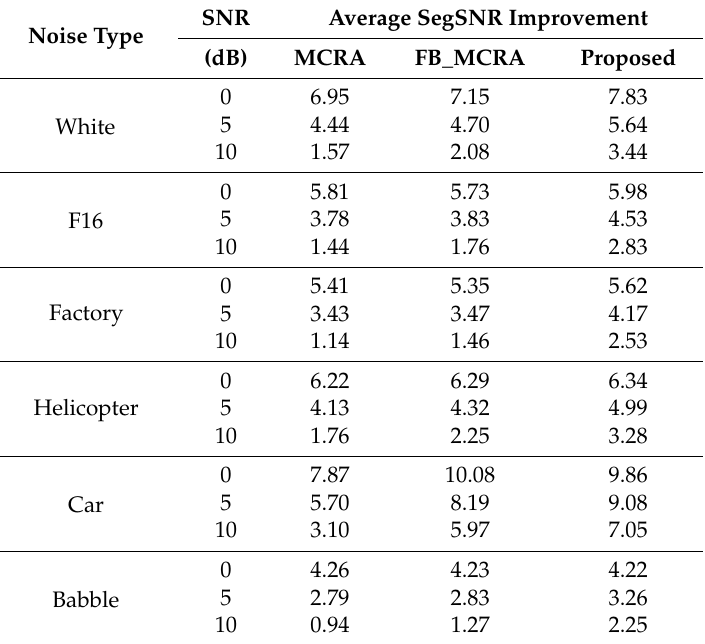
Table 1. Comparison of SegSNR improvement for the denoised speech in various noise